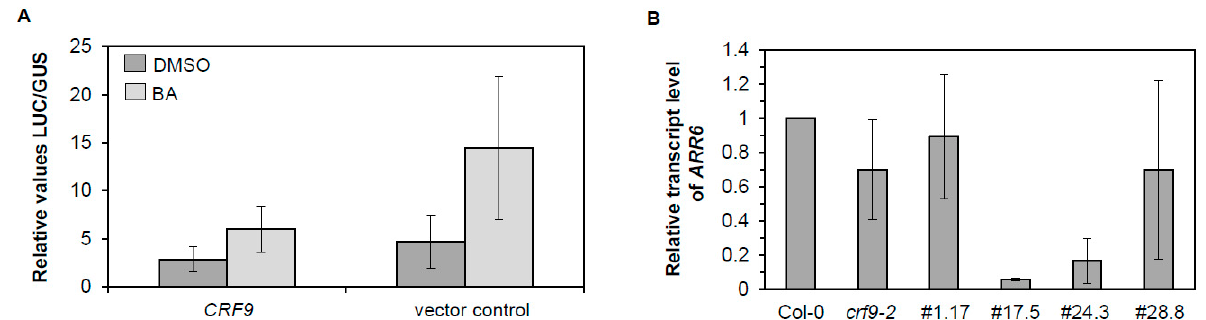
Figure 9. CRF9 acts as a transcriptional repressor of the cytokinin primary response gene ARR6 .